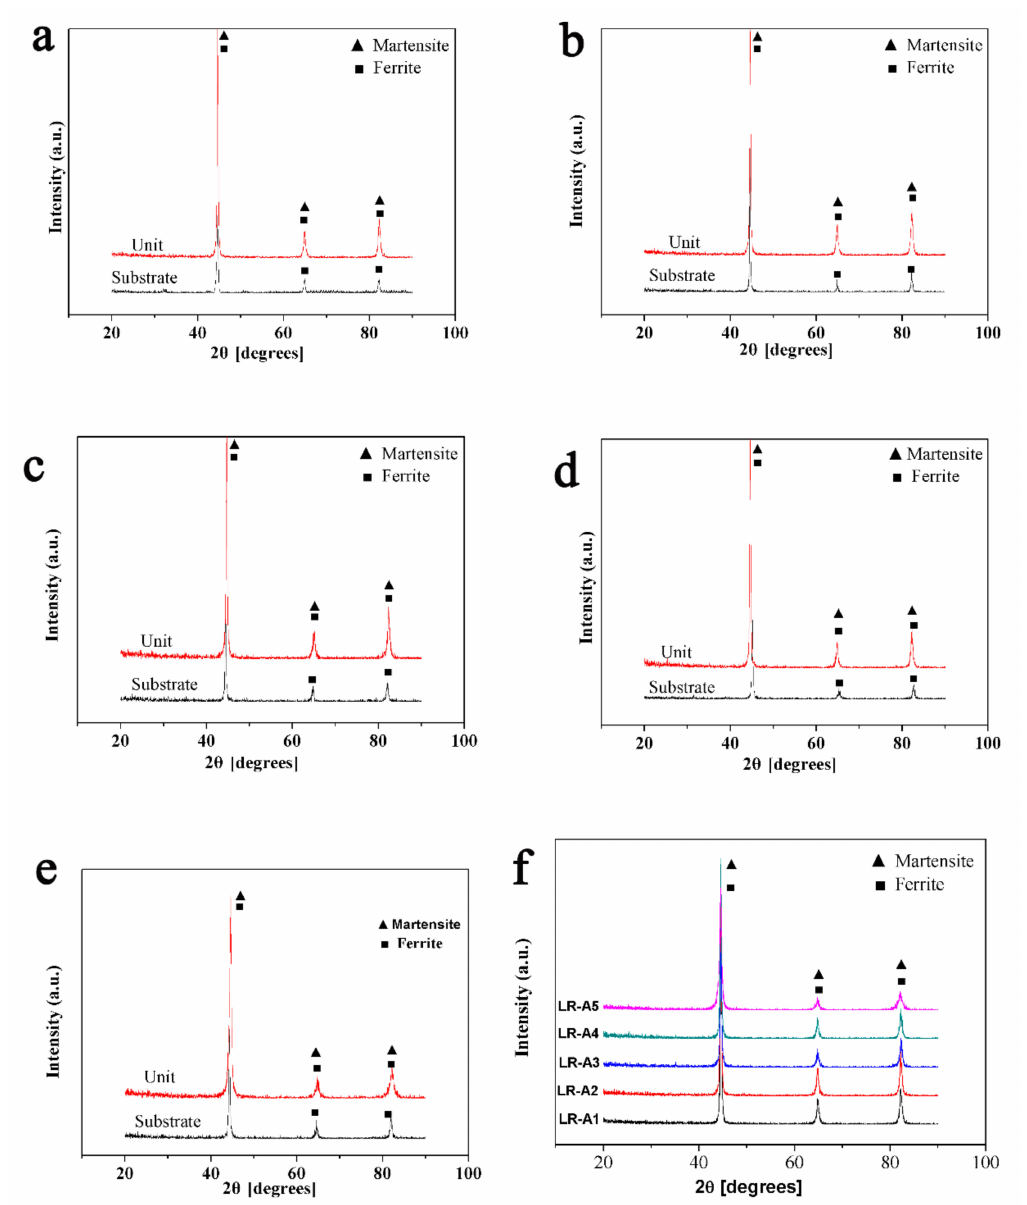
Figure 8. X-ray di ff raction profiles of the biomimetic units and matrixes: ( a ) A1, ( b ) A2, ( c ) A3, ( d ) -A4, ( e ) A5; ( f ) comparative di ff raction curves of